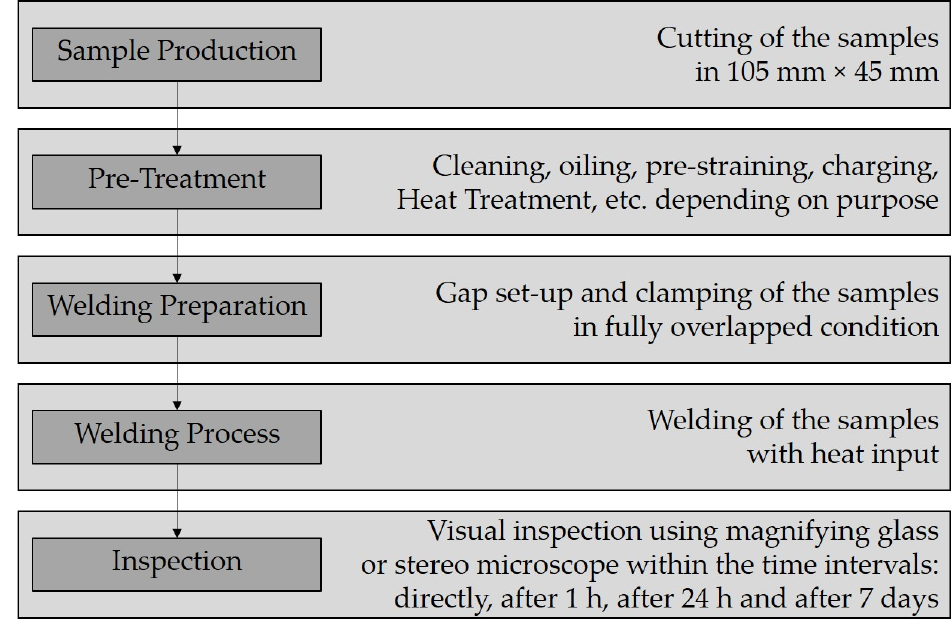
Figure 4. Exemplary steps of the cold cracking test procedure.